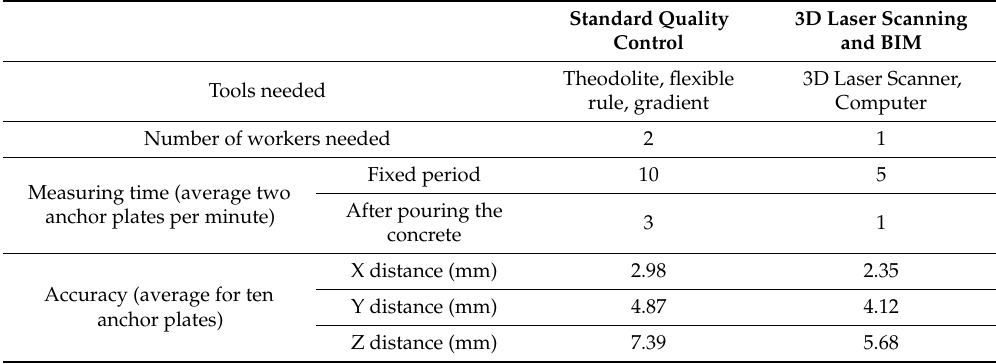
Table 5. Comparison of standard quality control and three-dimensional (3D) laser scanning and BIM